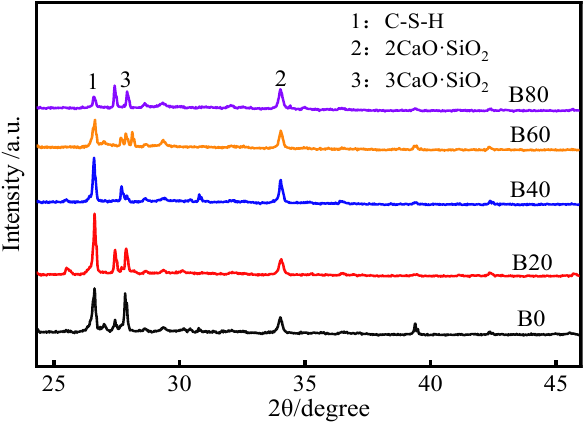
Figure 12. XRD pattern of mortar hydration products.